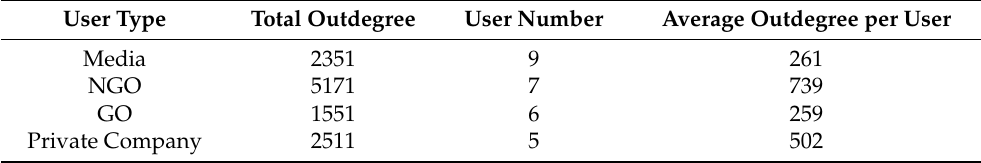
Table 4. Aggregated information of top